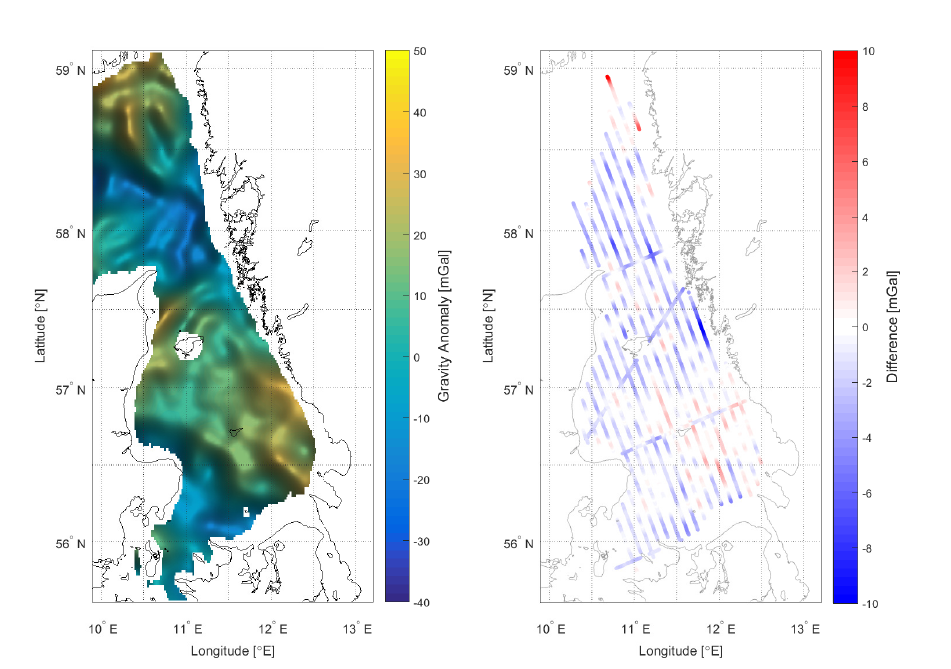
Figure A2. Gravity information from the DTU17 altimetry-derived gravity model. (Left): Gravity anomalies from the DTU17 model; (Right): Differences between bias adjusted iMAR estimates and upward continued gravity information from